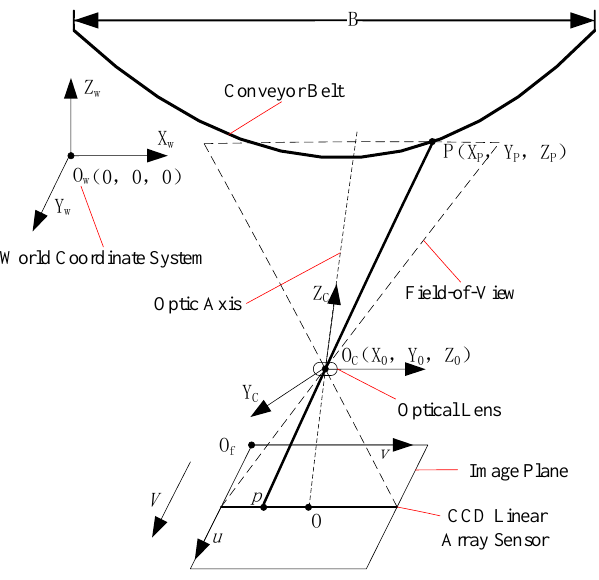
Figure 4. Imaging schematic diagram of the line-scan camera.